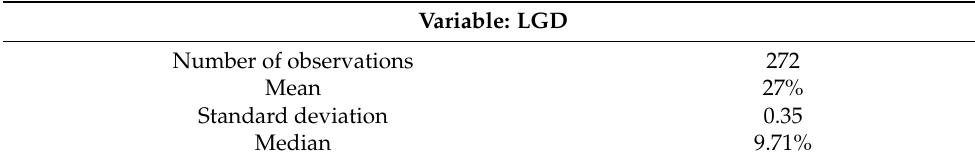
Table 11. LGD summary statistics of Country L.